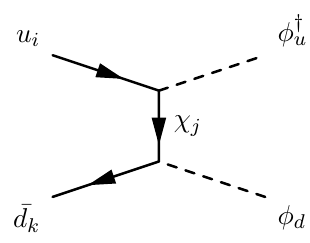
Figure 1 . Relevant production channel for (cid:30) u (cid:30) d mixed